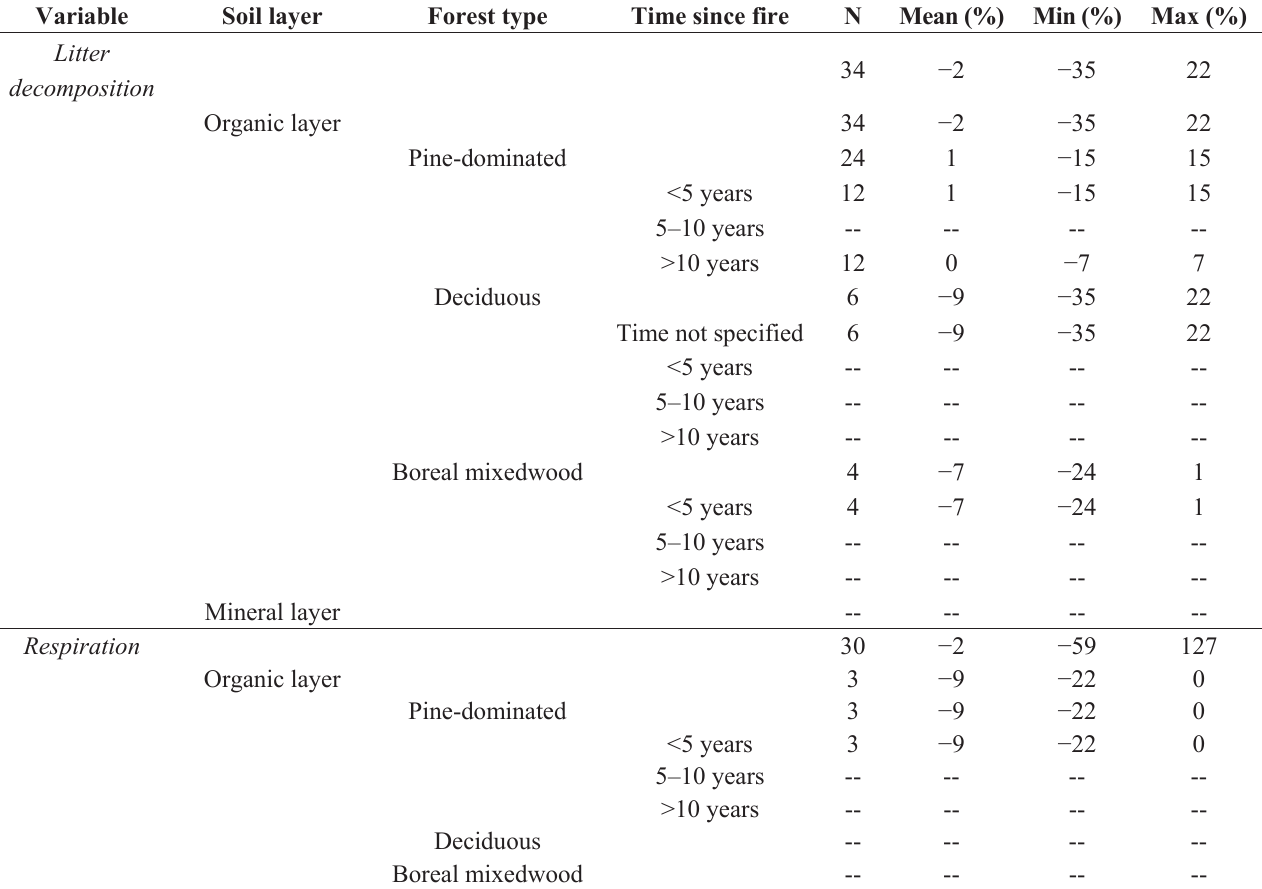
Table 6. Size and direction of fire effect on litter decomposition, soil respiration, N dynamics, and enzyme activities in Lake States forests by soil layer, forest type, and time since fire. Shown are number of observations in the literature that reported measurements from burned and reference (unburned) areas, and mean, minimum and maximum percent change relative to reference areas. Categories for which no data were reported for burned and reference areas are indicated by --. Values shown in rows for each variable, soil layer, and forest type major categories were calculated across all included